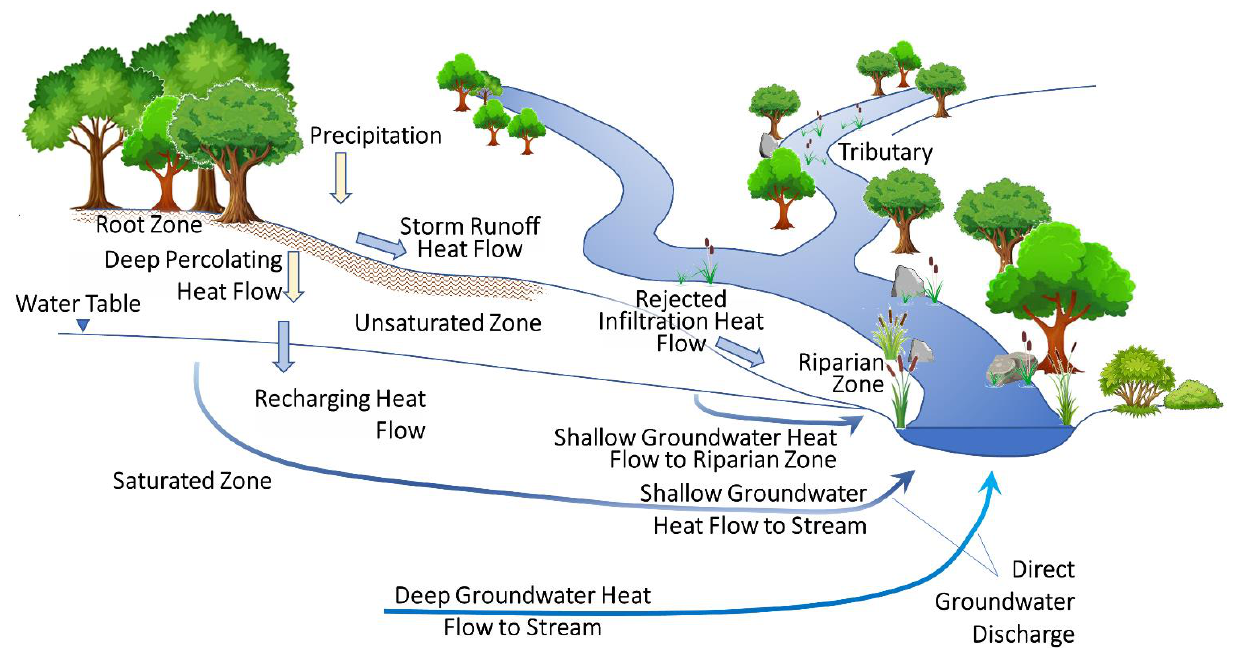
Figure 1. Schematic of heat-flow pathways through watershed.